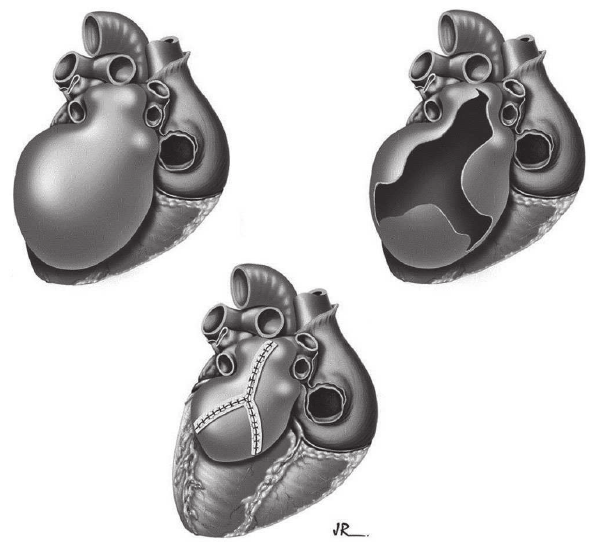
Fig. 7 - Desenho esquemático da reconstrução